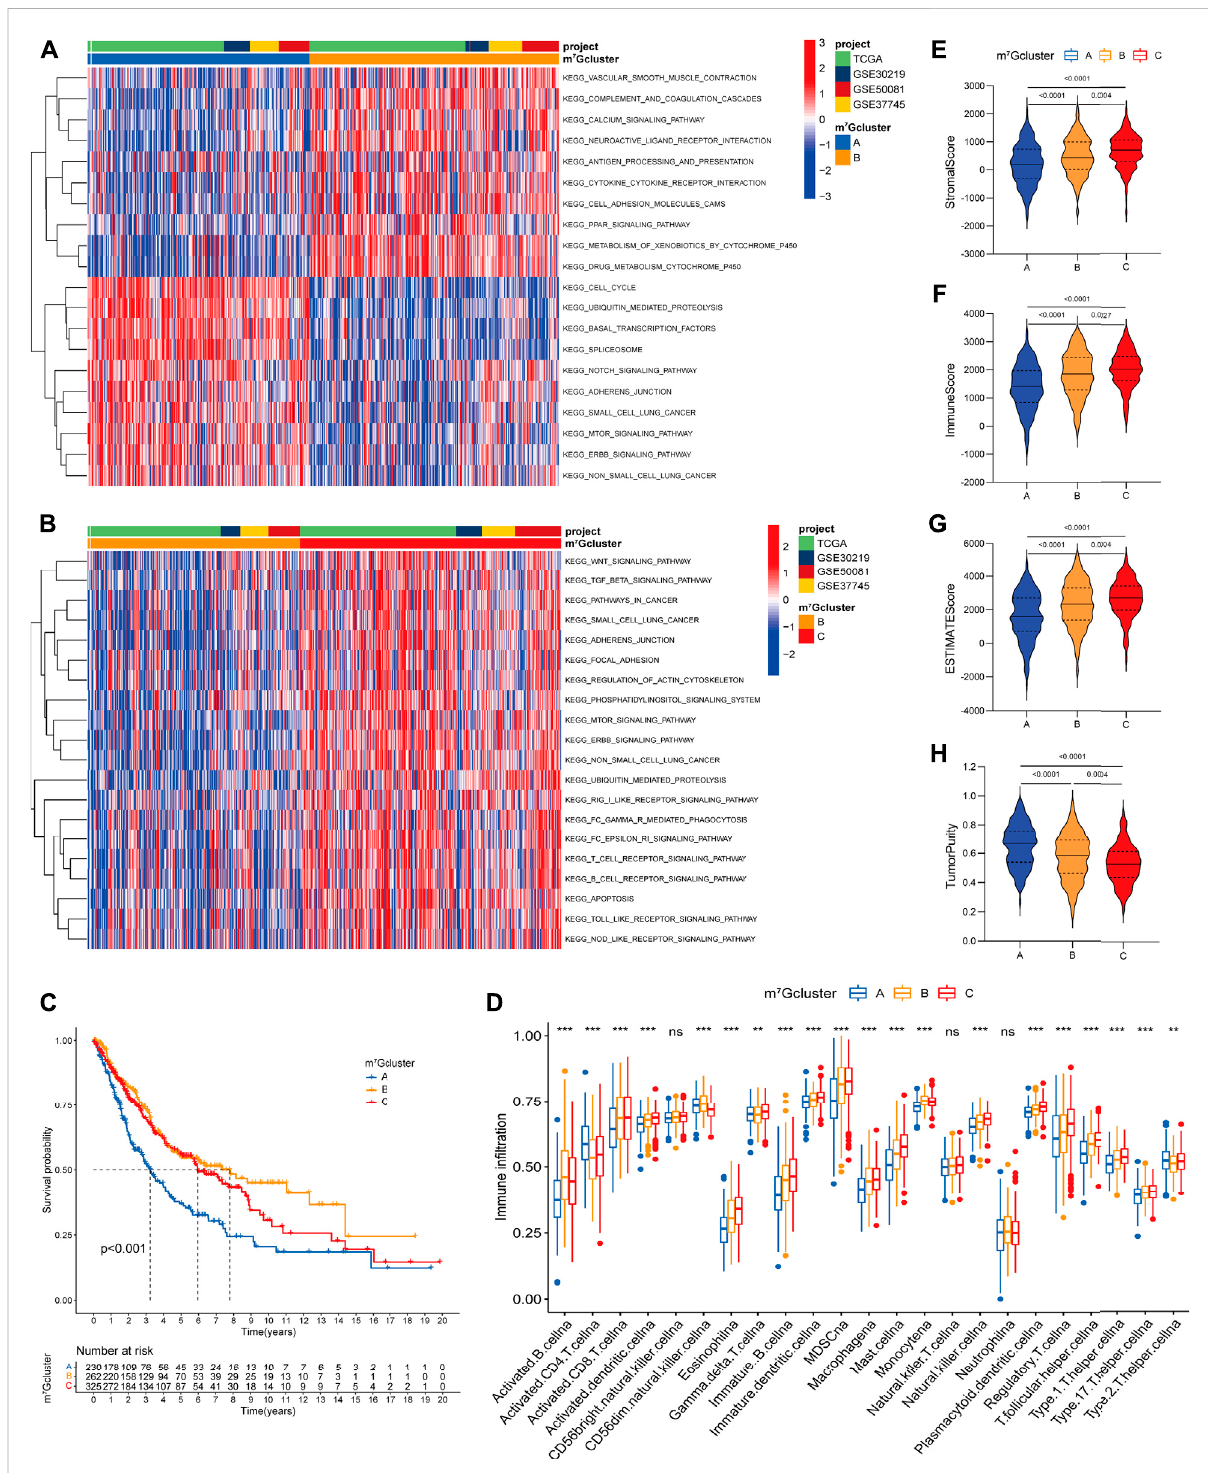
FIGURE 3 Biological characteristics and tumor microenvironment characterization of each m 7 G modi fi cation pattern. (A,B) The heatmap visualizes the enrichmentofbiologicalprocessesusingGSVAanalysisindistinctm 7 Gmodi fi cation patterns; (A) m 7 GclusterA vs.m 7 Gcluster B; (B) m 7 GclusterBvs. m 7 Gcluster C. Activated pathways are colored red and inhibited pathways are colored blue. The LUAD cohorts are used as sample annotations. (C) Survival analyses for the three m 7 G clusters based on 817 patients with LUAD from four cohorts (TCGA-LUAD, GSE30219, GSE50081, GSE37745). (D) The abundance of 23 TME in fi ltrating cells in the three m 7 G clusters. The horizontal line indicates the median, the lower and upper boundariesoftheboxestheinterquartilerange,andthedotstheoutliers.Asterisksindicatestatisticalsigni fi cance,* p < 0.05,** p < 0.01,*** p < 0.001. (E – H) Violin plots show differences in the (E) immune score, (F) stromal score, (G) ESTIMATE score and (H) tumor purity between distinct m 7 G